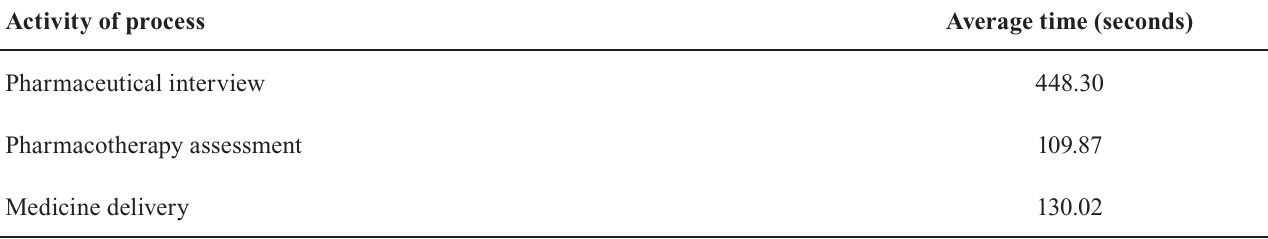
TABLE II - Average time of activities of medication dispensing service